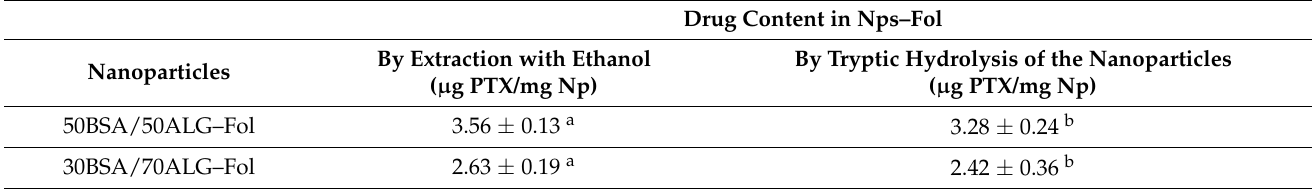
Table 3. Estimation of PTX content in folate-conjugated nanoparticles (Nps–Fol).